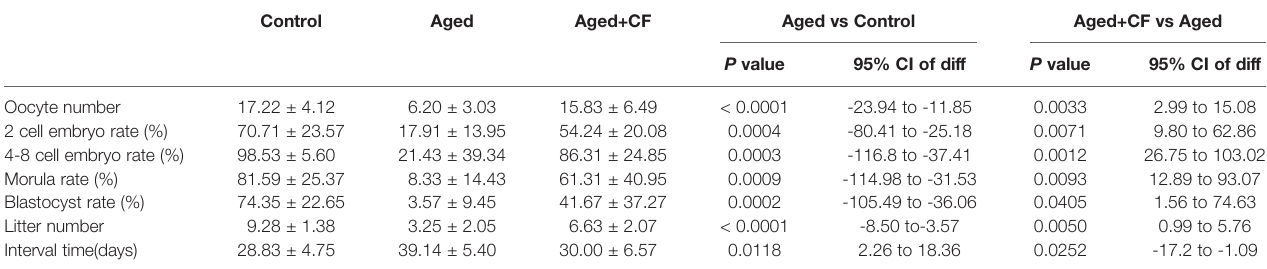
TABLE 2 | The statistics of oocyte number, 2 cell embryo rate, 4-8 cell embryo rate, morula rate, blastocyst rate, litter number and interval time.